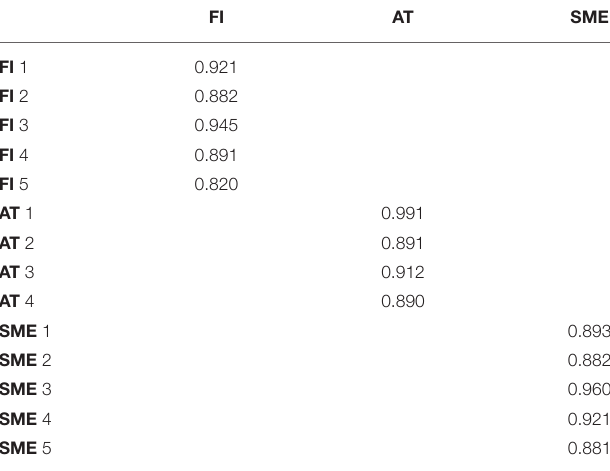
TABLE 4 | Validating the instrument used in the study.